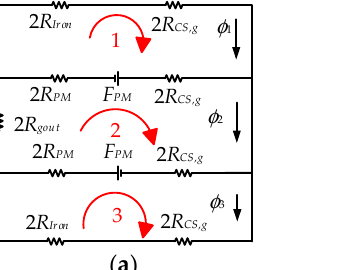
Figure 2. The magnetic circuit equivalent (MEC) model of the hybrid excited adjustable speed eddy current coupling (HE-ASECC). ( a ) permanent magnet (PM) excited. ( b ) I f excited.